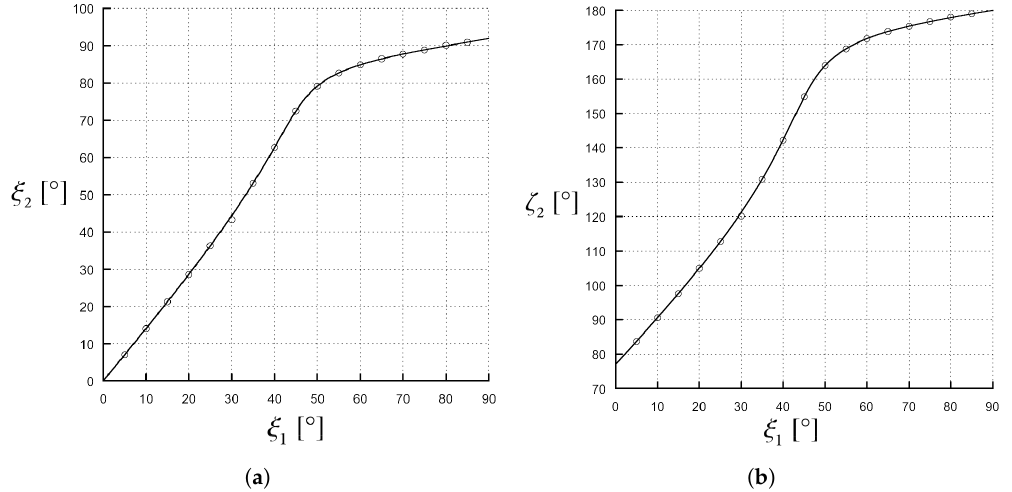
= 1, ε (cid:48)(cid:48) = 0.1 and β = 1.01 β 1 1 c . The angles 2 2